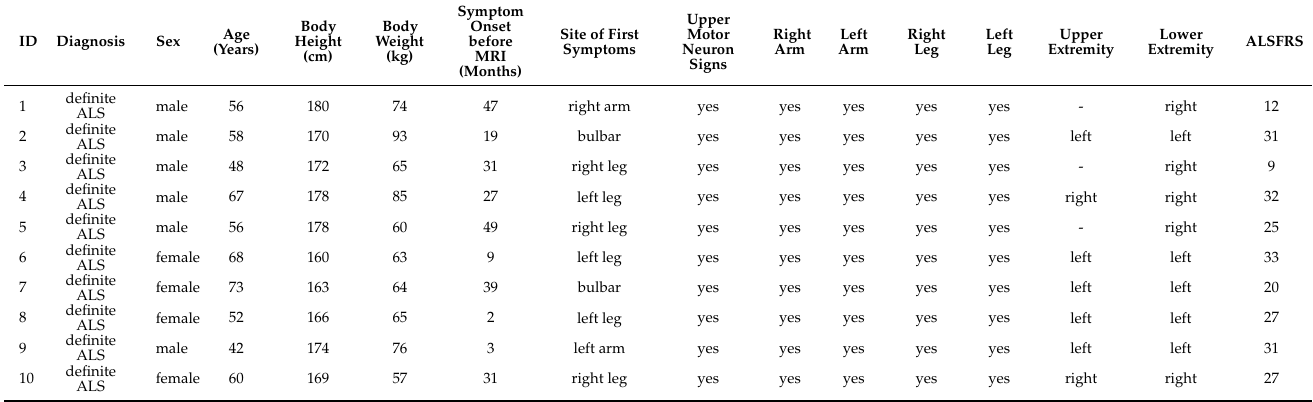
Table A1. Individual clinical/neurological characteristics of